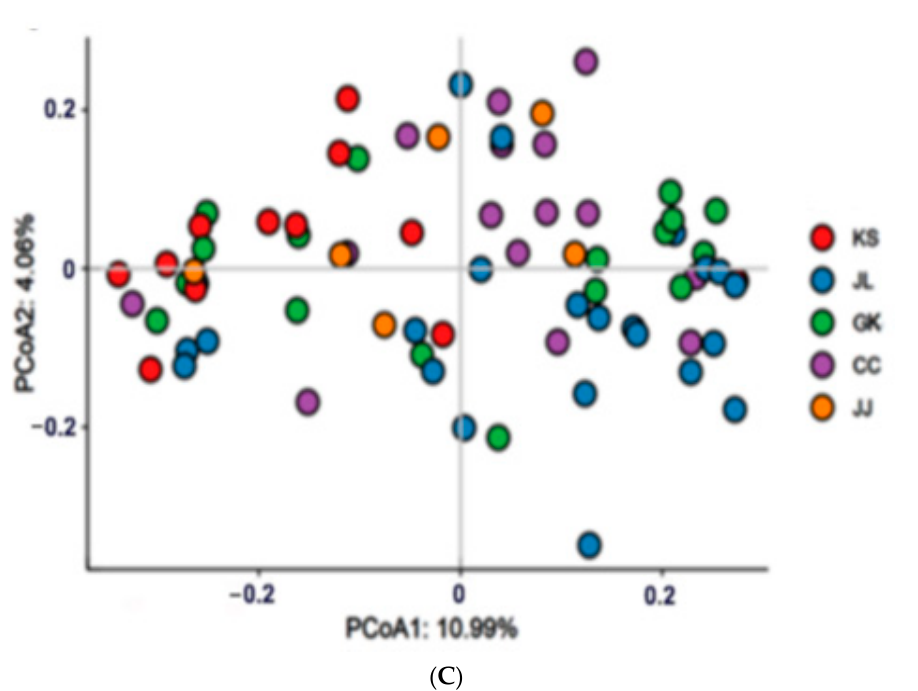
Figure 3. The richness of bacteria in traditionally made Kochujang (TMK). ( A ) Chao1 index for α -diversity. ( B ) Shannon index for α -diversity. ( C ) β -diversity. TMK samples from Jonlla (Chonbuk+Chonnam; n = 23), Kyungsang ((KS) Kyungbuk+Kyungnam; n = 12), Gyungkang ((GK) Gyunggi-Do+Kwangwon; n = 17), and Chungcheung provinces ((CC) Chungbuk + Chungnam; n = 15) and Jeju island ((JJ); n = 6) of Korea. a and b: Different letters on the bars indicate significant differences among the groups by Tukey test ( p < 0.05).